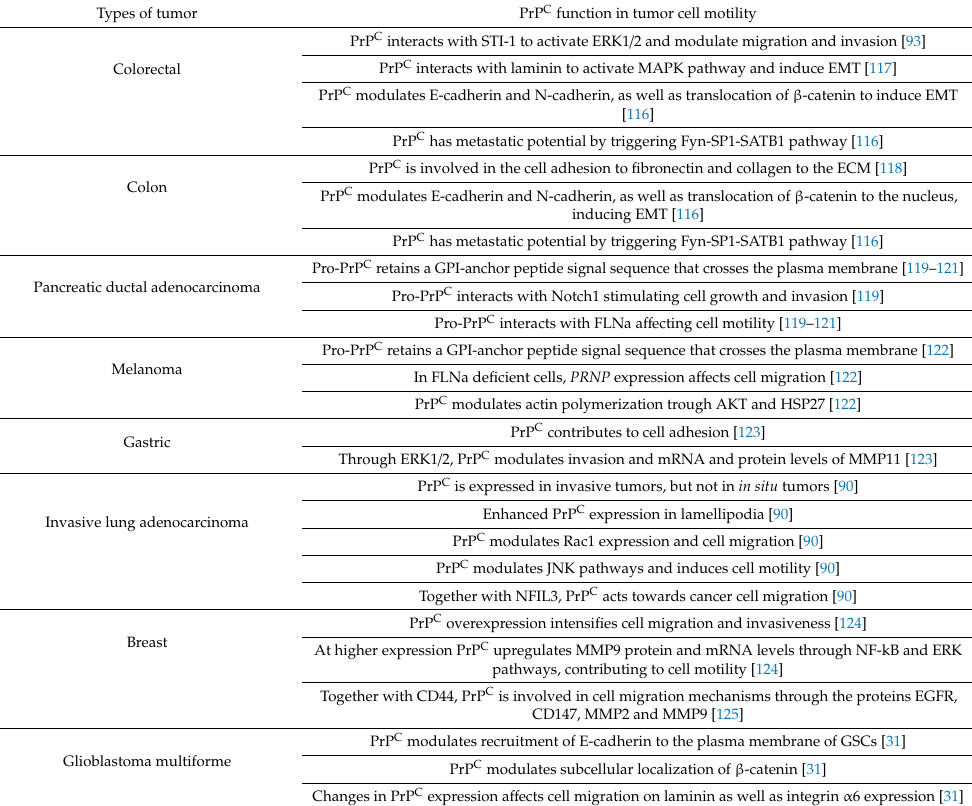
Table 1. List of tumors along with respective PrP C functions associated with the modulation of invasion and metastasis